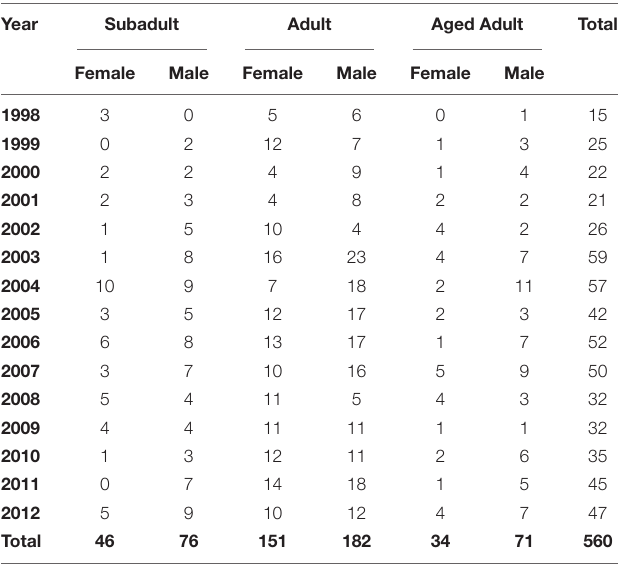
Table 1 . The nutritional condition of otters in this study were: 224 emaciated, 63 thin, 61 fair, 92 good, and 116 excellent (four unknown). Eighty-six otters were previously tagged for rehabilitation or